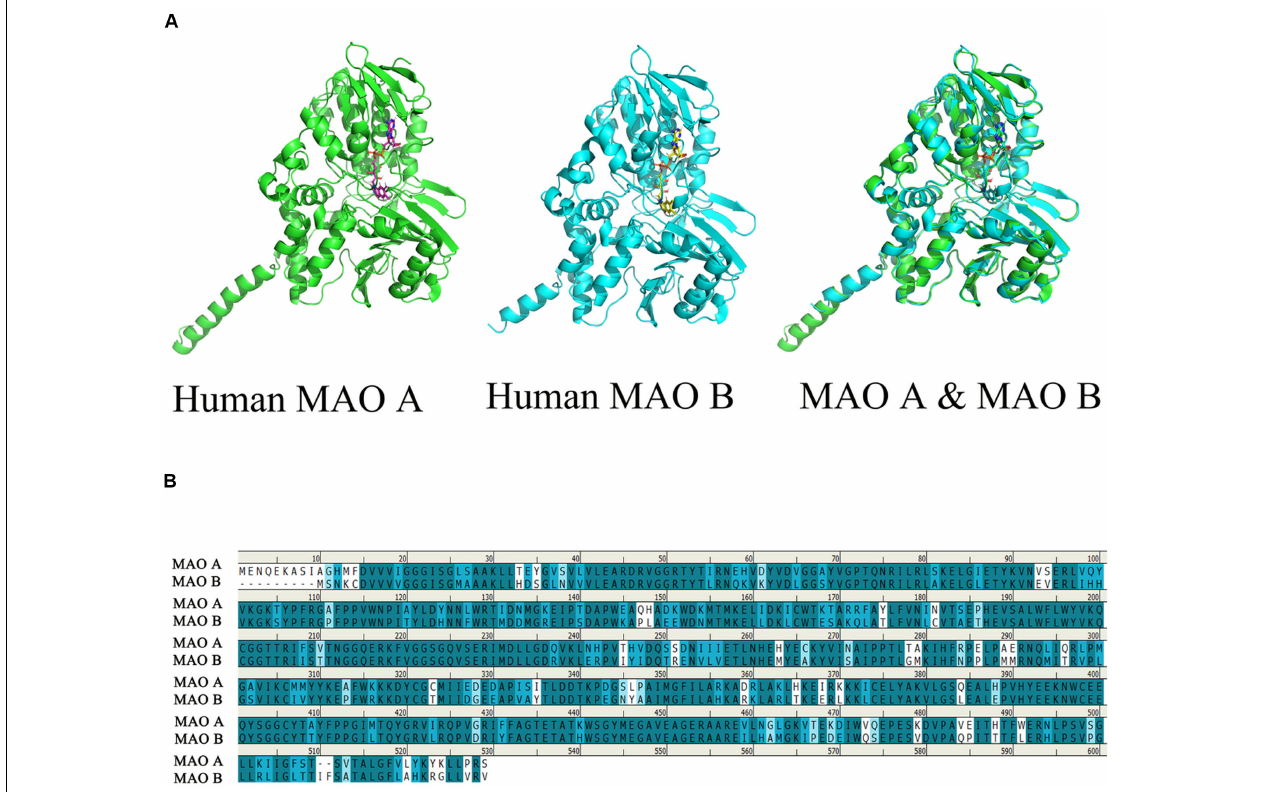
FIGURE 1 | Comparison of the structure of human MAO A and human MAO B . The picture is generated by PyMOL (Son et al., 2008). Use clustalw in MEGA software to perform multiple sequence alignment, generate alignment result files, and import the aligned sequences into geneDoc software for visualization (Boratyn et al., 2019). (A) Observe the overlapping structure of human MAO A and human MAO B in three-dimensional space. The same part between the two structures is shown in cyan. (B) Amino acid sequence identity comparison, blue is the sequence with higher similarity, the darker the color, the higher the similarity, the overall sequence identity between MAO A and MAO B is about